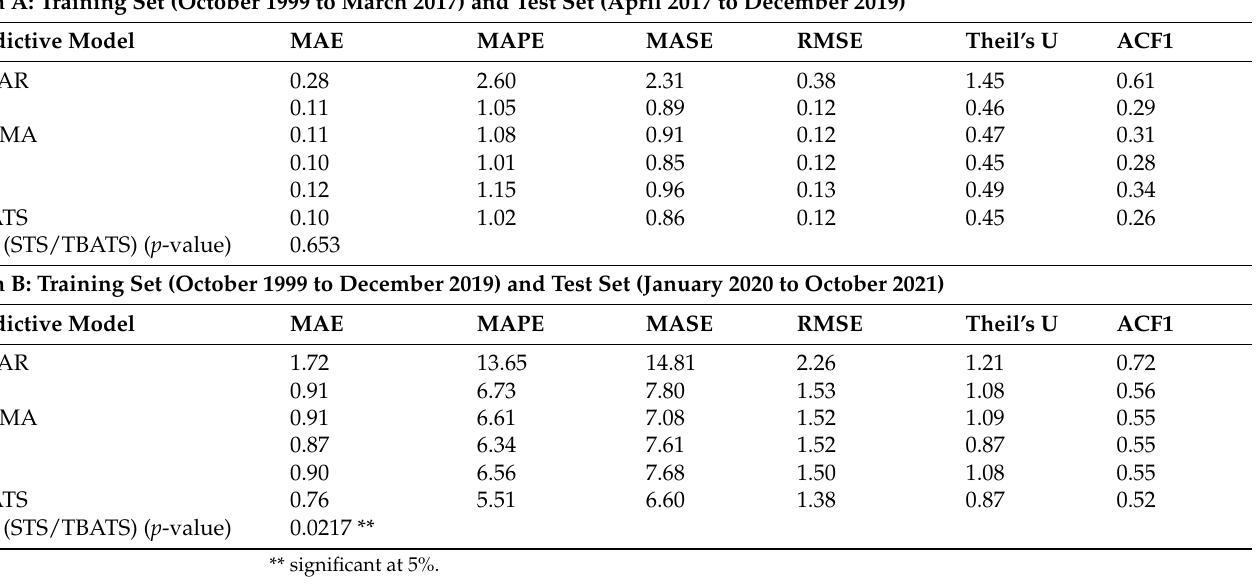
Table 2. Performance metrics for the six models on ECOMPCTSA (path A and path B).